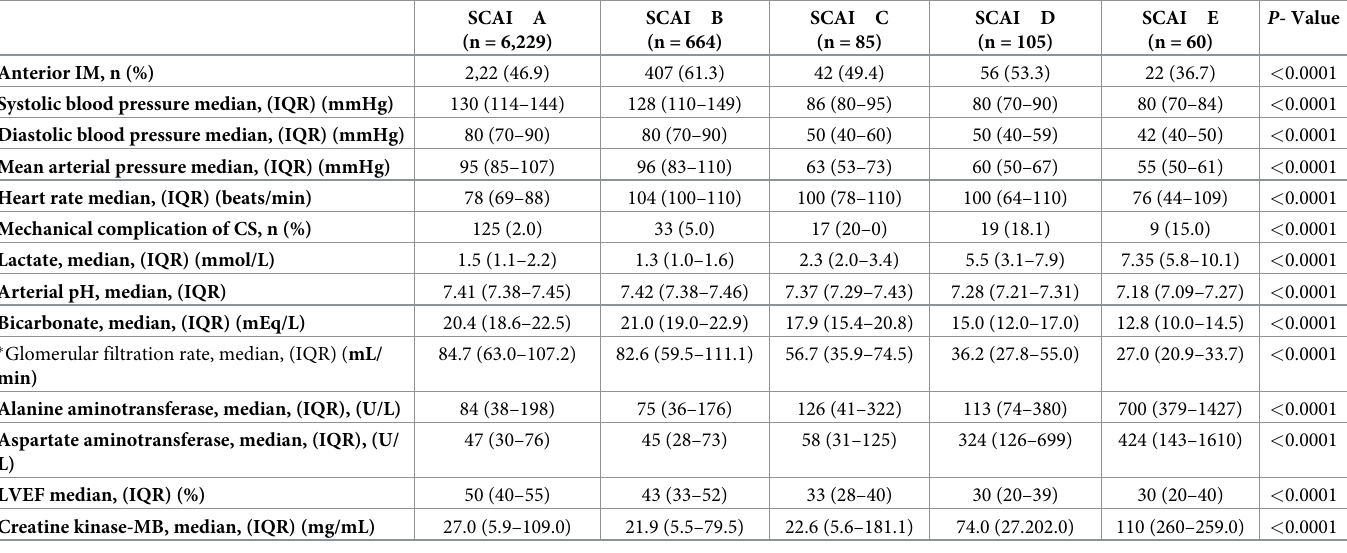
Table 2. Clinical features and laboratory data at admission of according to per society for cardiovascular angiography and intervention cardiogenic shock stage.